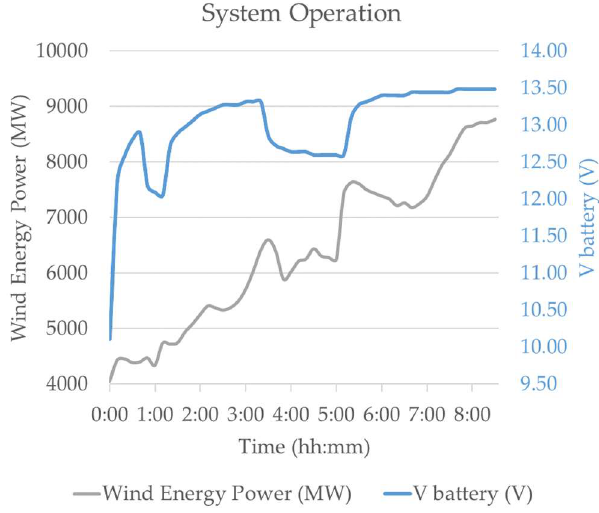
Figure 10. Charging process of a forklift and wind energy production as reported by the supplier.